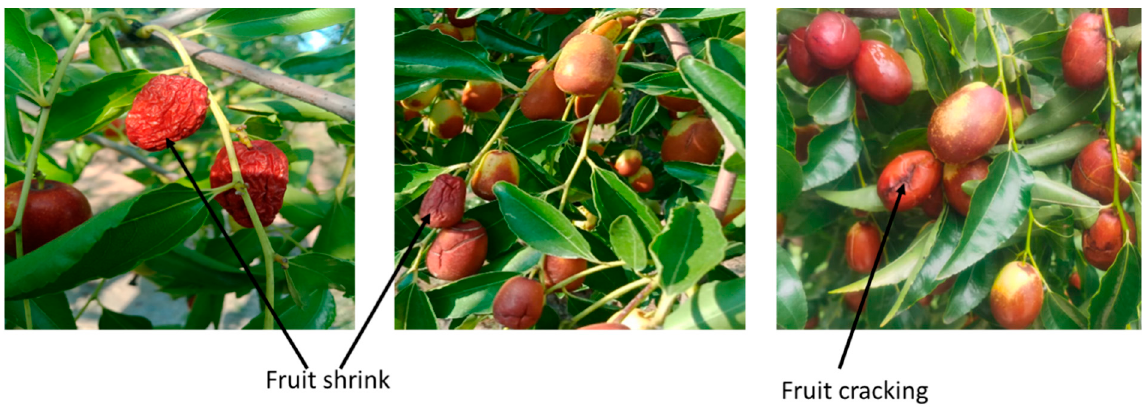
Figure 7. Fruit shrink and fruit cracking of Z. jujuba.